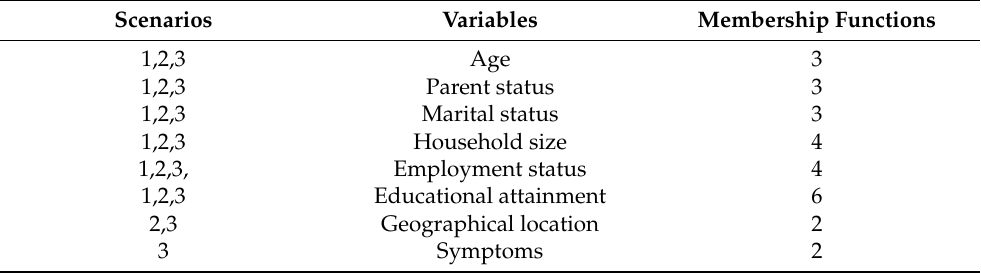
Table 3. Amount of membership functions for each input variable of the fuzzy logic